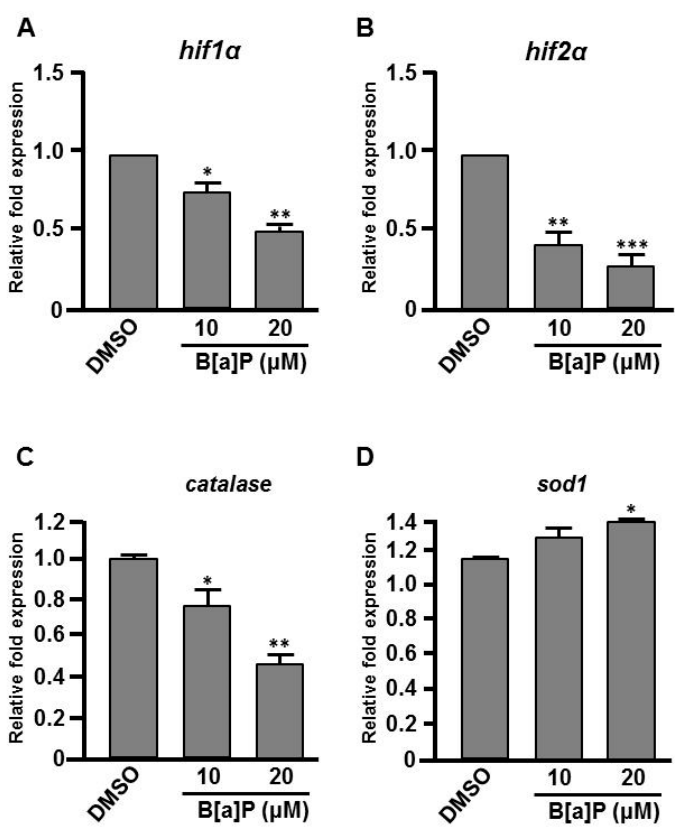
Figure 5. Expression levels of Hifs and oxidative stress-related genes are altered in B[a]P treated embryos. Zebrafish embryos were exposed to 0 μ M. (control, 01% DMSO), 10 and 20 μ M of B[a]P from 2 hpf until 24 hpf. Expression of genes encoding ( A ) Hif1 α , ( B ) Hif2 α , ( C ) Catalase and ( D )Sod1 was examined by real-time quantitative RT–PCR. * p < 0.05, ** p < 0.01, *** p < 0.001 compared with the control.